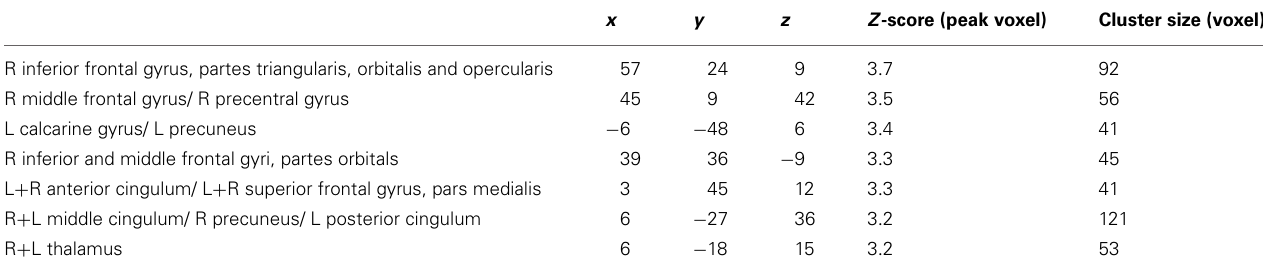
Table 3 | Brain areas with differential training (NECT) specific changes in their responses to emotional and neutral non-verbal cues from voice and face.